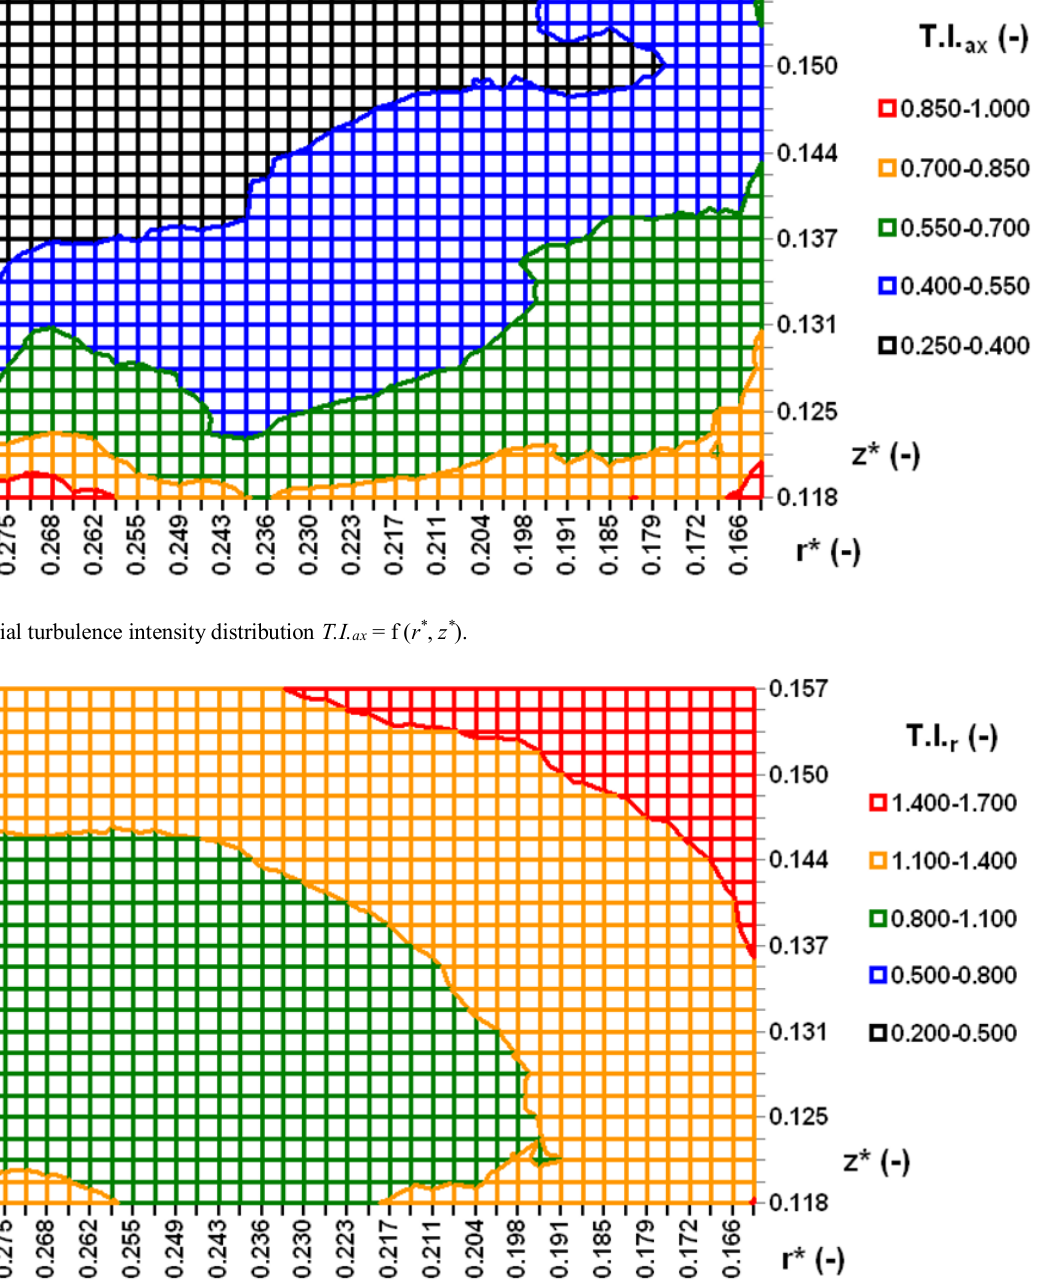
Fig. 13. Radial turbulence intensity distribution T.I. r = f ( r * , z *